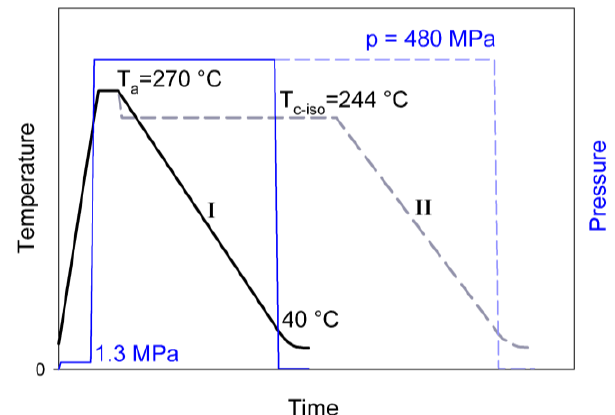
Figure 1. Pressure-temperature protocol of the high pressure crystallization: route I—nonisothermal crystallization (solid lines), route II—isothermal crystallization (dashed lines).